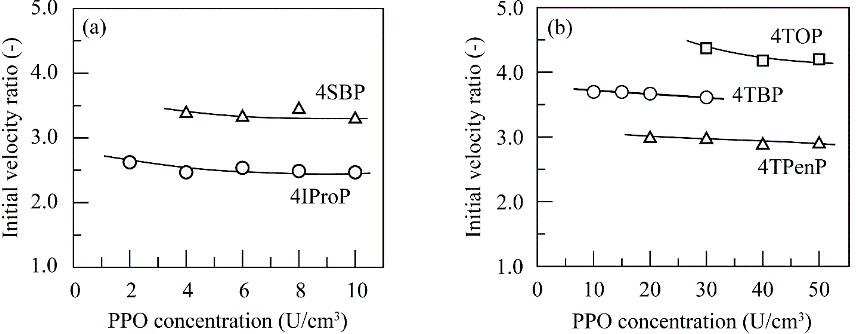
Figure 5. Changes in the initial velocity ratio with the PPO concentration for ( a ) 4IProP ( ○ ) and 4SBP ( △ ); and ( b ) 4TBP ( ○ ), 4TPenP ( △ ), and 4TOP ( □ ) at pH 7.0 and 40 °C. Chitosan beads were dispersed in alkylphenol solutions without PPO at pH 7.0 and 40 °C, and